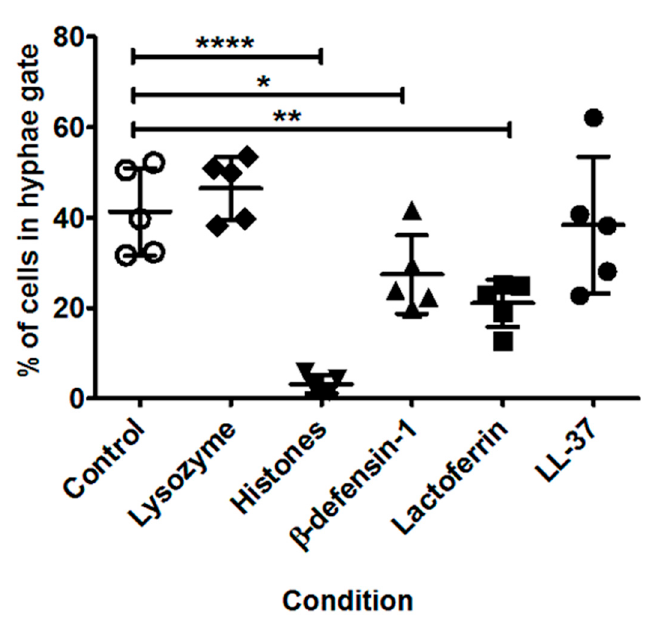
Figure 6. Average percentage of cells in the hyphae gate for each AMP for the five A. fumigatus strains analysed combined. Strains were incubated with antimicrobial peptides and proteins (AMPs) for 10 h at 37 ◦ C. AMP concentrations were: 80 µ M lysozyme, 100 µ g / mL histones, 10 µ M β -defensin-1, 40 µ M lactoferrin and 12.5 µ M LL-37. After incubation, cells were fixed in 4% paraformaldehyde and analysed using imaging flow cytometry. The data represents a single experiment per strain and mean values for all strains ± SD are shown. * p < 0.05; ** p < 0.005 and **** p < 0.0001 as assessed by two-tailed T test. Mean hyphae lengths of the strains when grown under control conditions were 57.9 µ